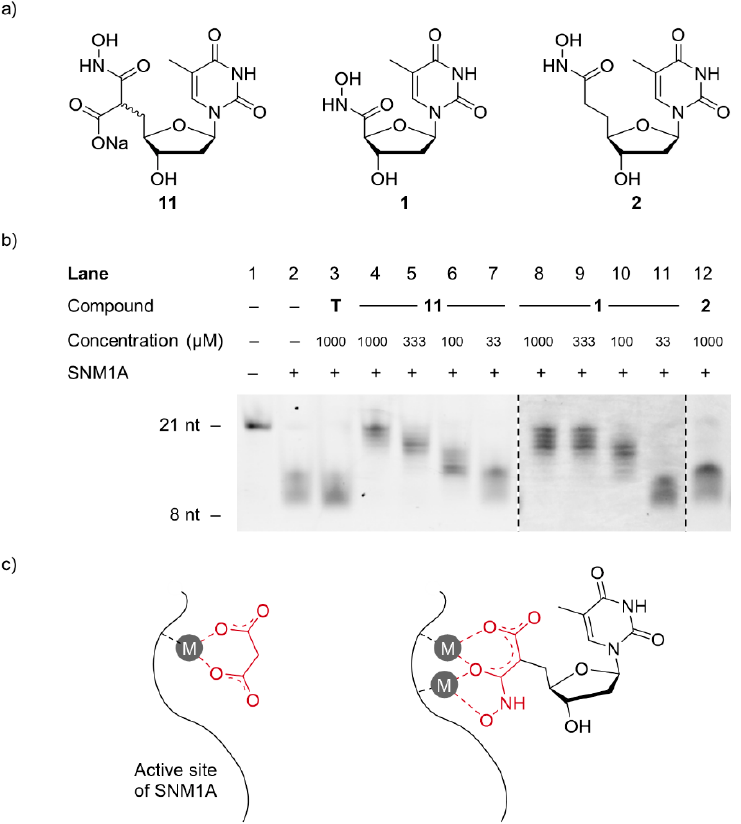
Figure 5. Comparison of previously reported compounds 1 and 2 and compound 11 and the pro- posed binding mode. ( a ) Structures of compounds 1 , 2 and 11 . ( b ) Inhibition of SNM1A by compounds 1 , 2 and 11 at various concentrations. ( c ) The observed binding mode of malonate anion in the active site of SNM1A and the proposed binding mode of compound 11 .